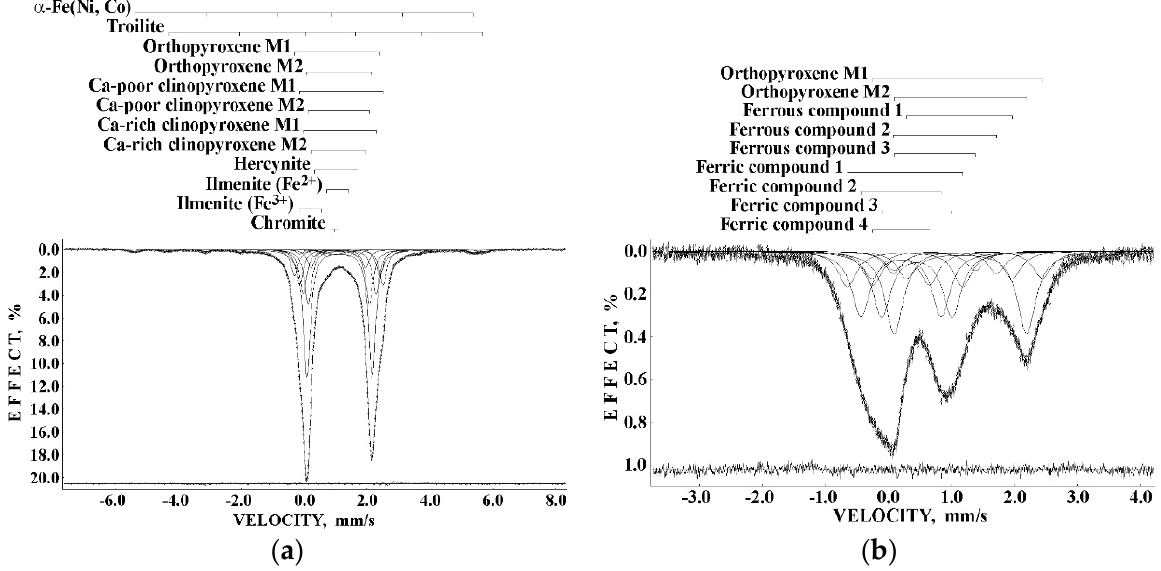
Figure 9. Room temperature Mössbauer spectra of Sariçiçek howardite measured with a high-velocity resolution: the bulk interior ( a ) and the fusion crust ( b ). Indicated components are the results of the best fits. The differential spectra are shown on the bottom. Adapted from [25].